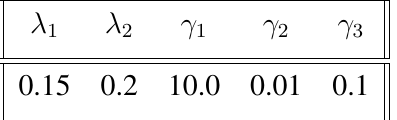
Table 1: Parameters used in the regularizer, Eq.